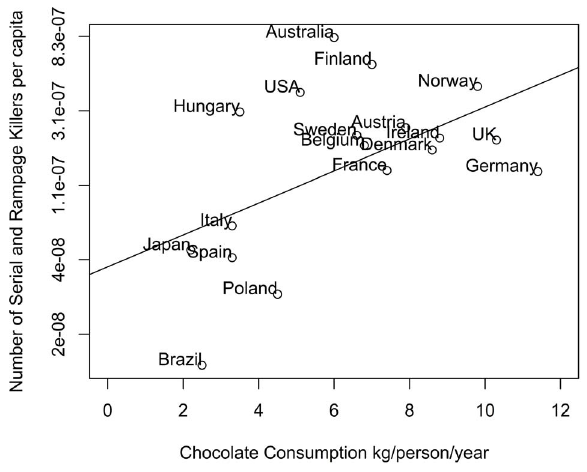
Figure 10. Chocolate consumption per capita (kg) as a function of the log number of serial and rampage killers per capita since 1900.